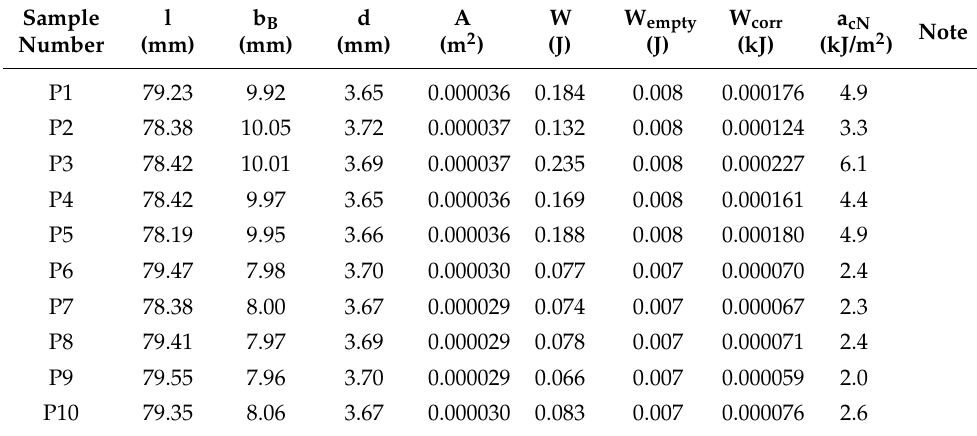
Table A25. Results of the notched impact tests and unnotched impact tests of